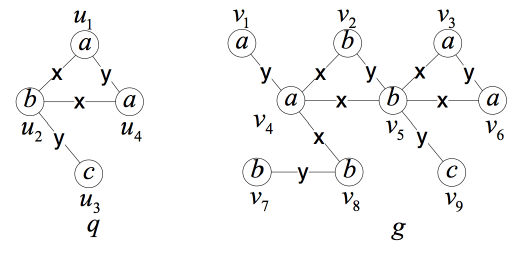
Figure 2. An example of subgraph